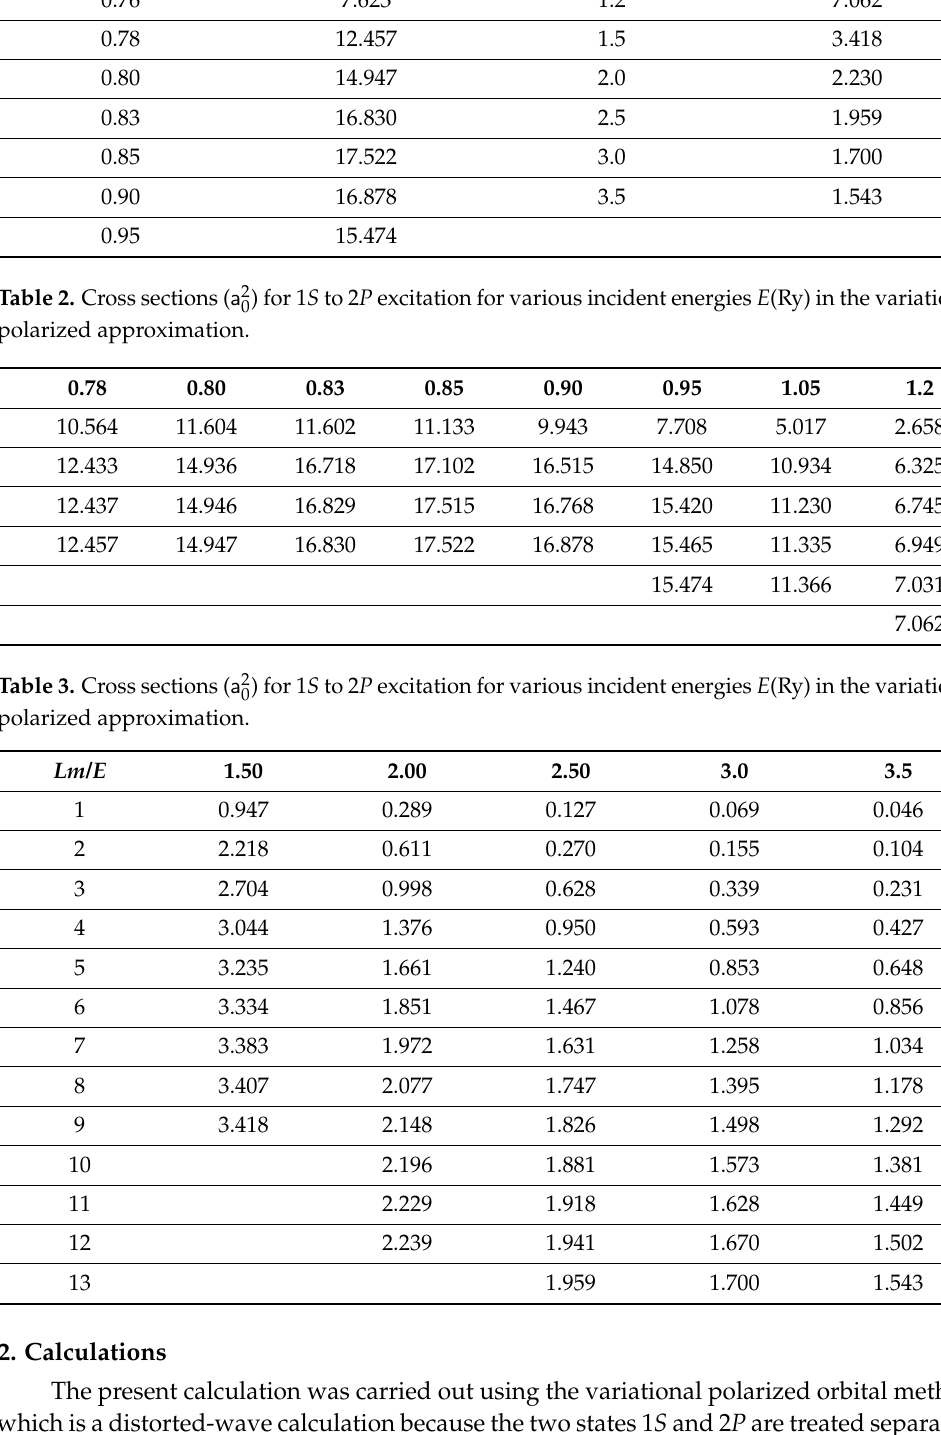
Table 1. Present excitation cross sections σ ( a 2